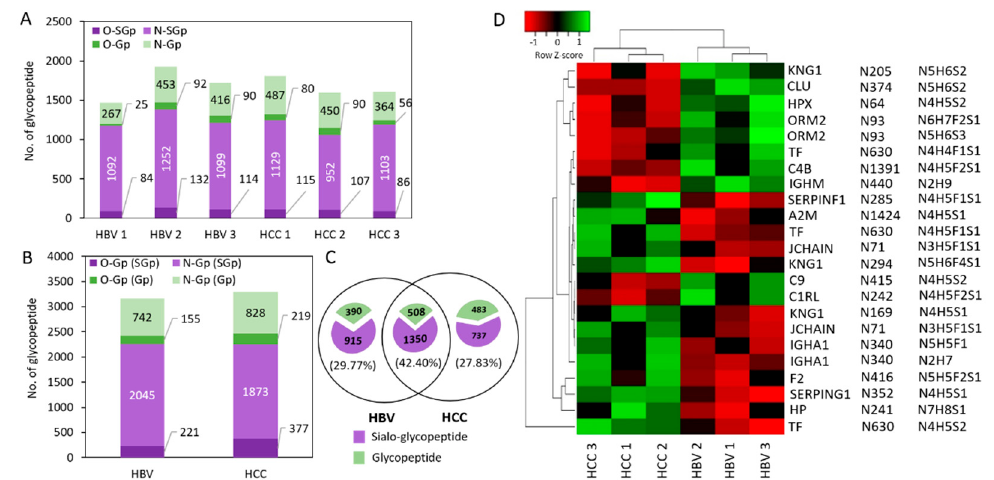
Figure 5. Exploring the differential glycopeptide from individual serum HBV and HCC patients. ( A ) Comparison of unique N-glycopeptide and O-glycopeptide identified from individual HBV and HCC serum and ( B ) two patient cohorts. ( C ) Venn diagram of unique glycopeptide identified from two patient cohorts. ( D ) Hierarchical heatmap of differential glycopeptide abundance using Euclidean distance and complete linkage.